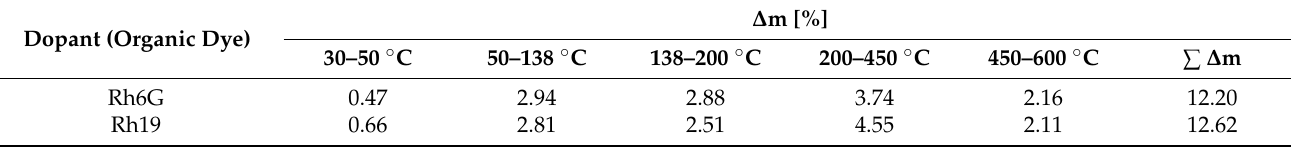
Table 2. Differences between individual mass loss values for annealed